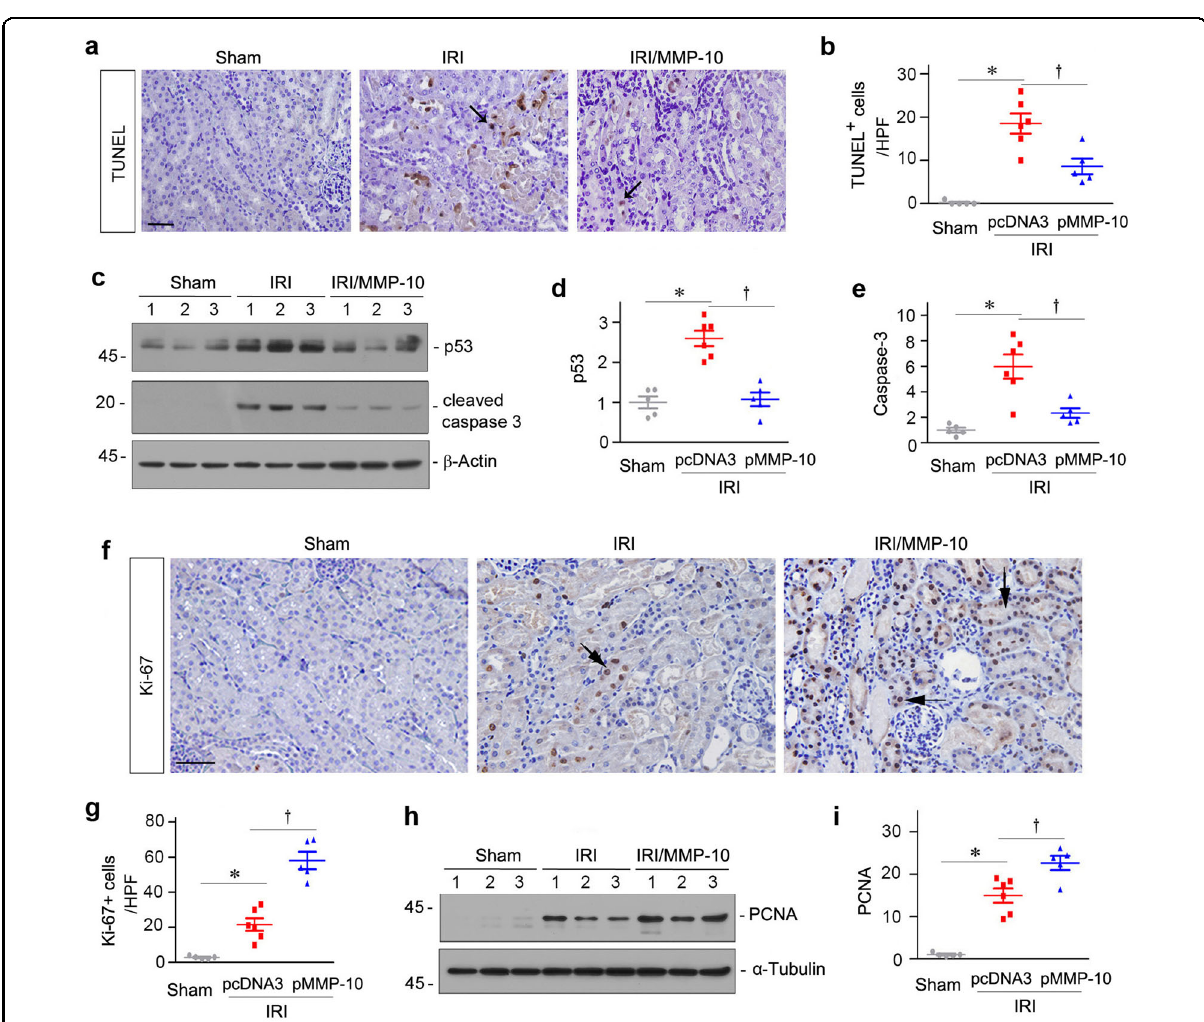
Fig. 3 Exogenous MMP-10 inhibits tubular cell apoptosis and promotes tubular repair after IRI. a Representative micrographs show TUNEL +